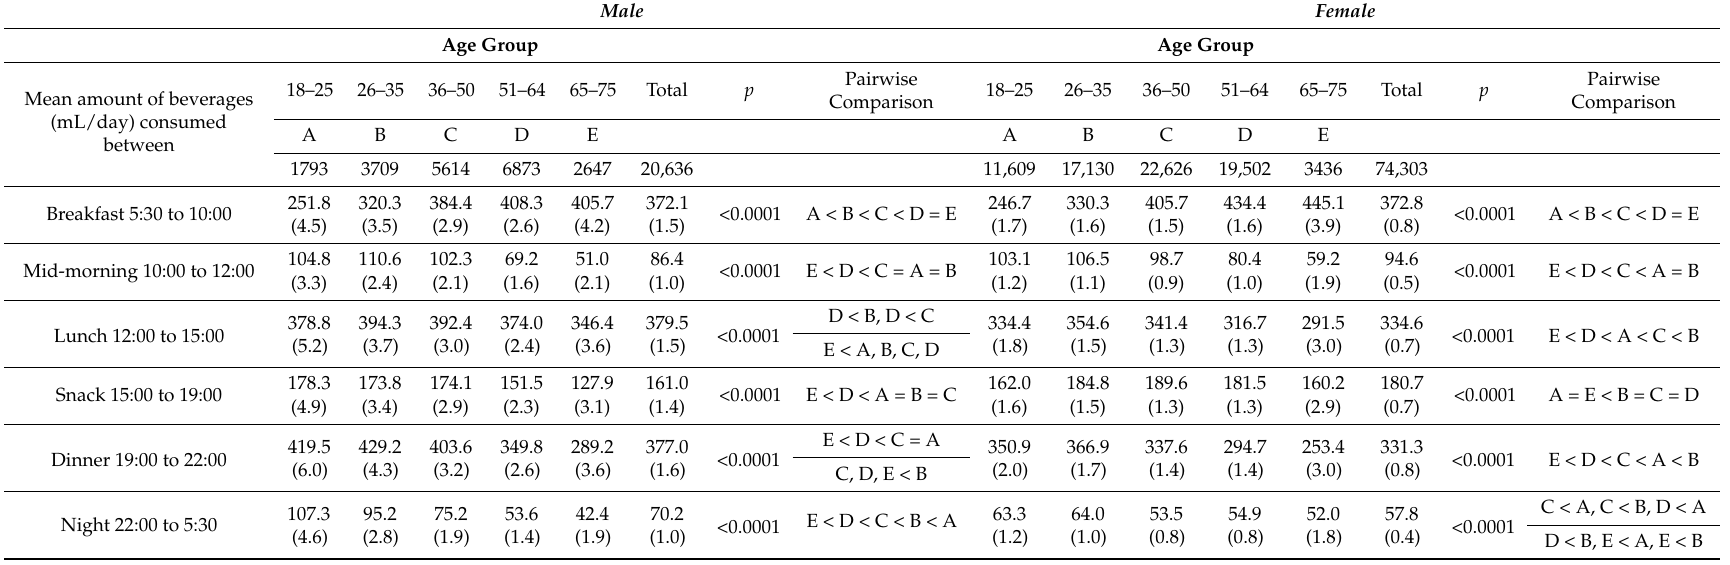
Table 6. Beverage consumption according to time of day (hour interval), by gender and by age group. Male Female Age